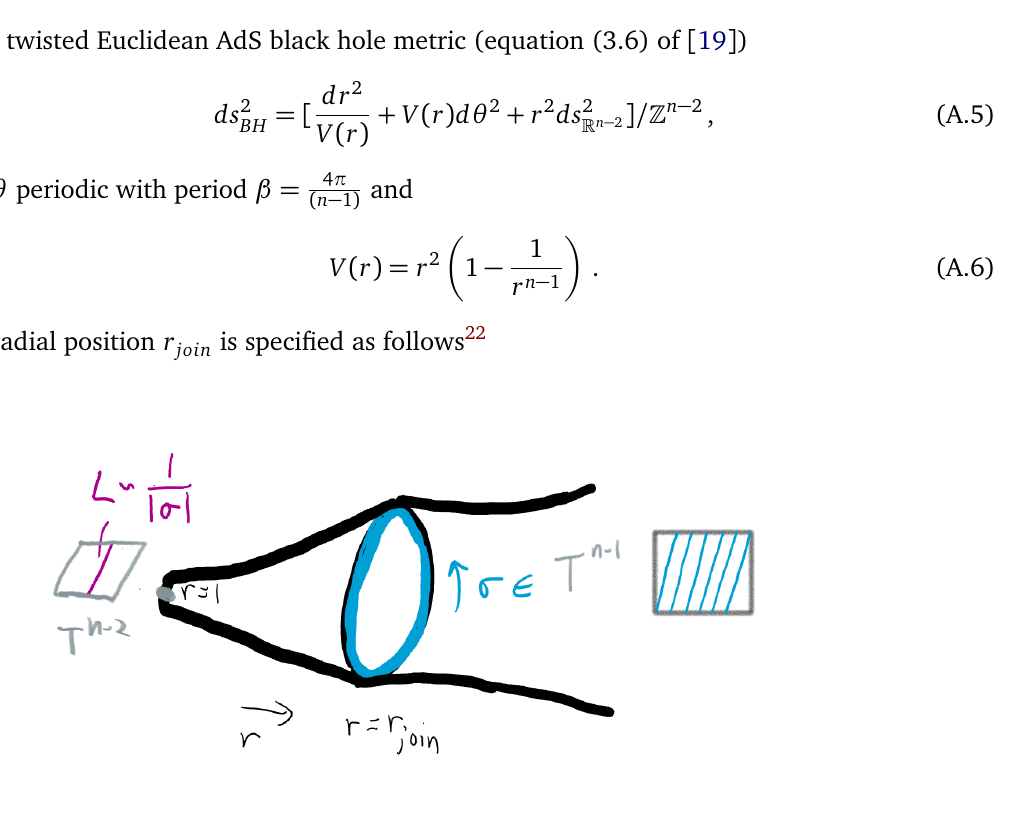
Figure 14: A schematic of the approximate filled metric in the construction [ 19 ] , joined to the cusp at r = r , as reviewed in the text. A choice of long simple closed join geodesic σ provides a tunably small systole at the tip of the cigar. The joined metrics (cid:112) V | > 1, but one can smooth this (A.4) and (A.5) have a corner at r since d join r join dr out and perturb slightly to obtain an Einstein metric throughout [ 19 ]